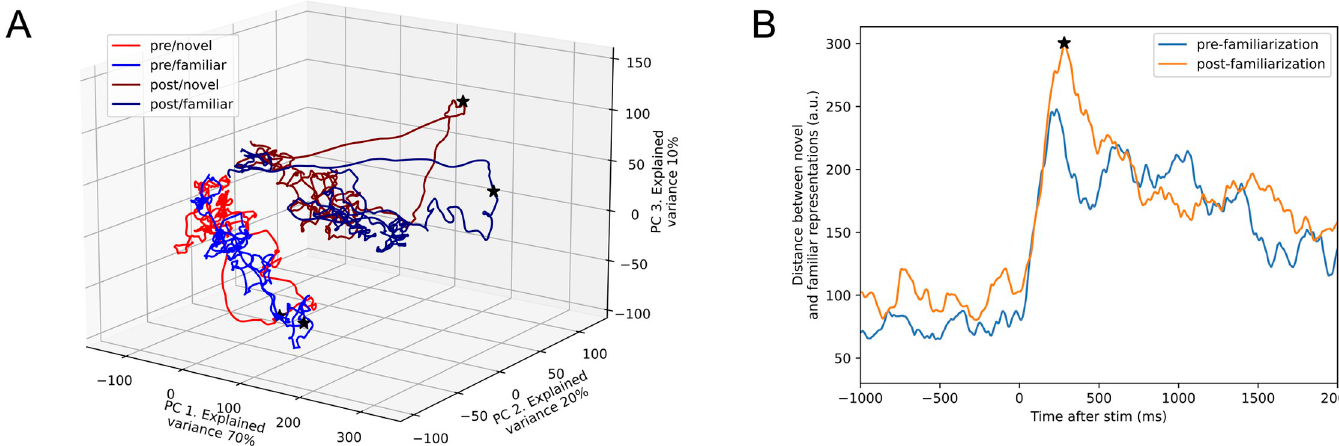
Fig 5. Familiarization enlarges the differences between familiar- and novel-odor representations in AL. ( A ) Principal components of firing rate of PN responses to familiar- and novel-odor before and after the familiarization process (pooled across hex-familiarized and oct-familiarized PNs). Black stars mark the time points where the peak response was. After familiarization, the novel odor evoked a response that showed distinct prominence at peak response relative to all other presentation types. ( B ) Familiarization produced increases in the distance between the novel and familiar PN response (pooled across hex-familiarized and oct-familiarized PNs). Black star occurs at the same time as in A. Stimulus onset was at